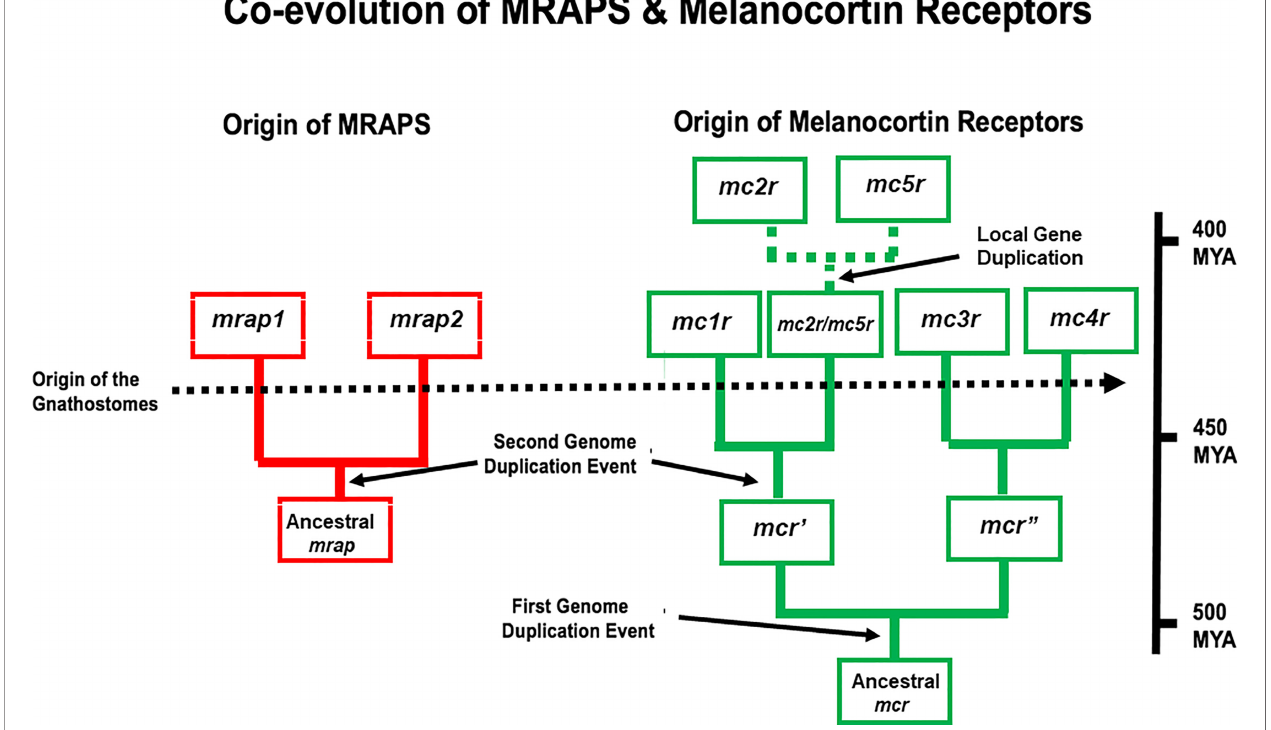
FIGURE 2 | A schematic representation of genome duplication events in the proposed co-evolution of MRAPs and MC2Rs. This fi gure is modi fi ed from (25). In this scenario, the ancestral melanocortin gene ( mcr ) was duplicated as a result of the R1 genome duplication event to give rise to mcr ’ and mcr ” . As a result of the R2 genome duplication event, four paralogs emerged mc1r , mc3r, mc4r , and mc2r/mc5r . This scenario proposes that distinct mc2r and mc5r paralogs were the result of a local gene duplication event that occurred in the ancestral gnathostomes. In this scenario, the ancestral mrap gene evolved in R1 agnathan vertebrates and duplicated to yield the mrap1 and mrap2 genes as a a result of the R2 genome duplication event. MYA, millions of